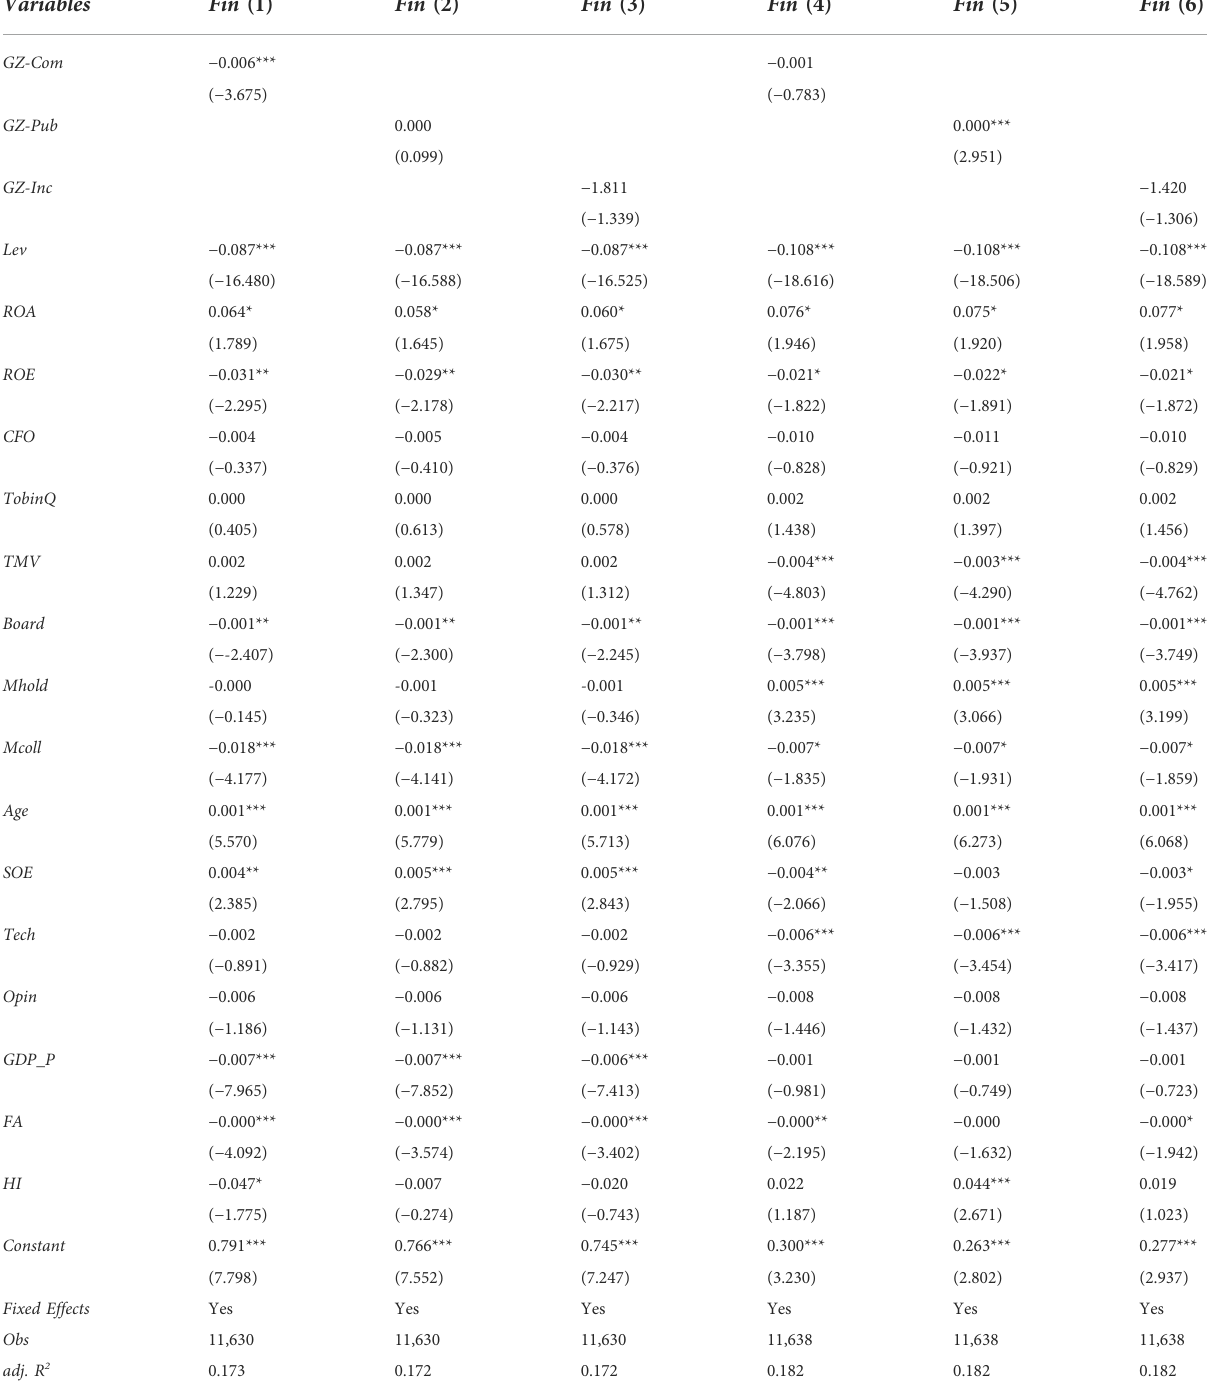
TABLE 10 Grouping test results of fi rm